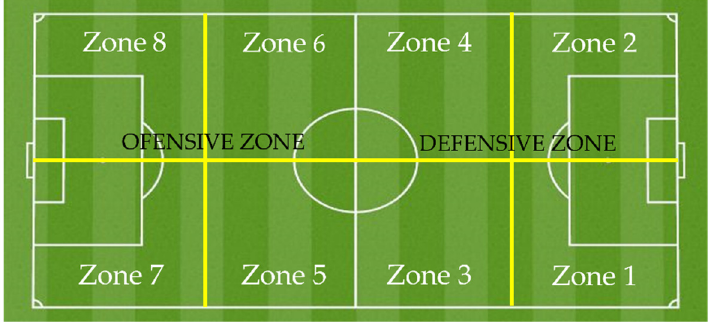
Figure 1. Field areas.